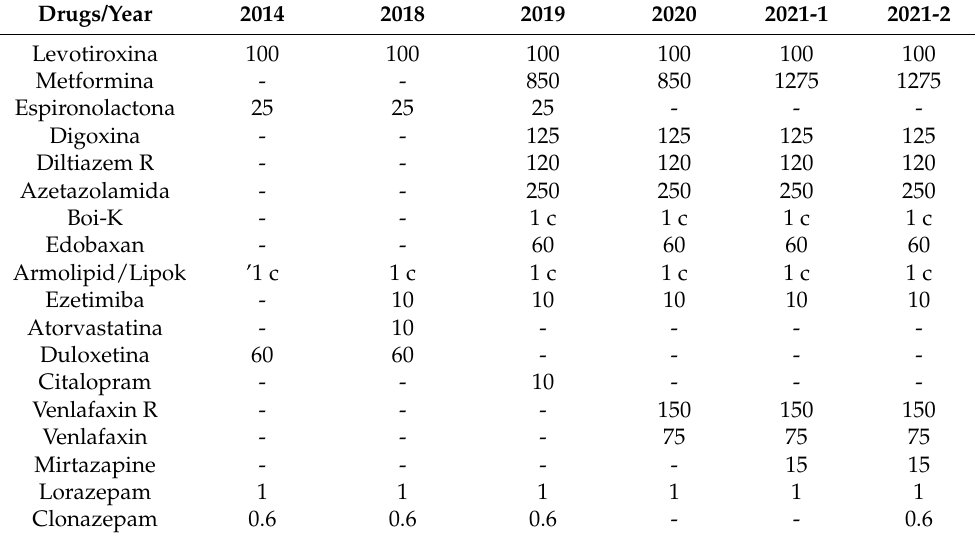
Table 1. Evolutive drug